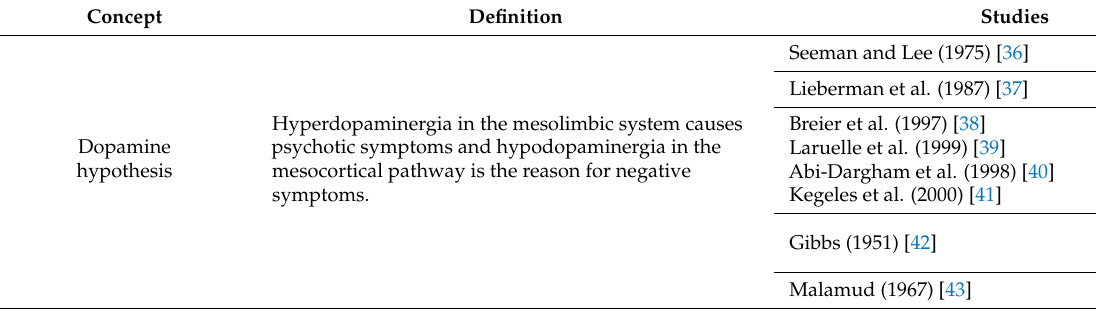
Table 1. Etiological frameworks of